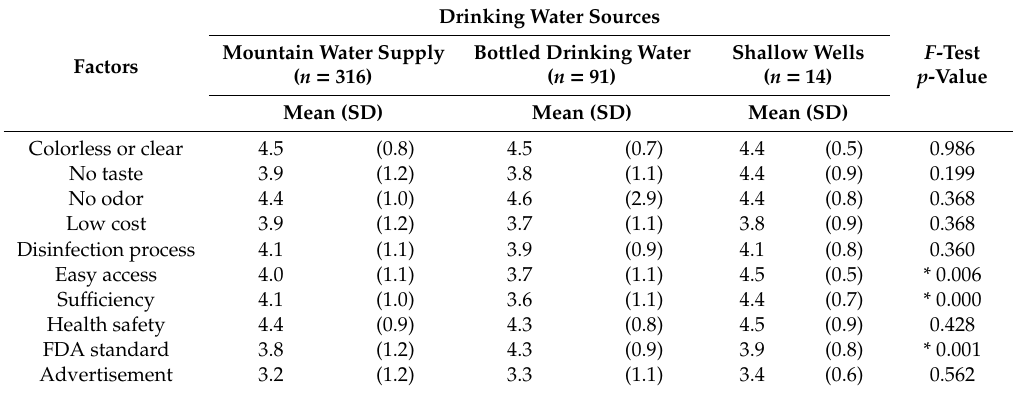
Table 3. Influencing factors of drinking water selection from three sources of drinking water.